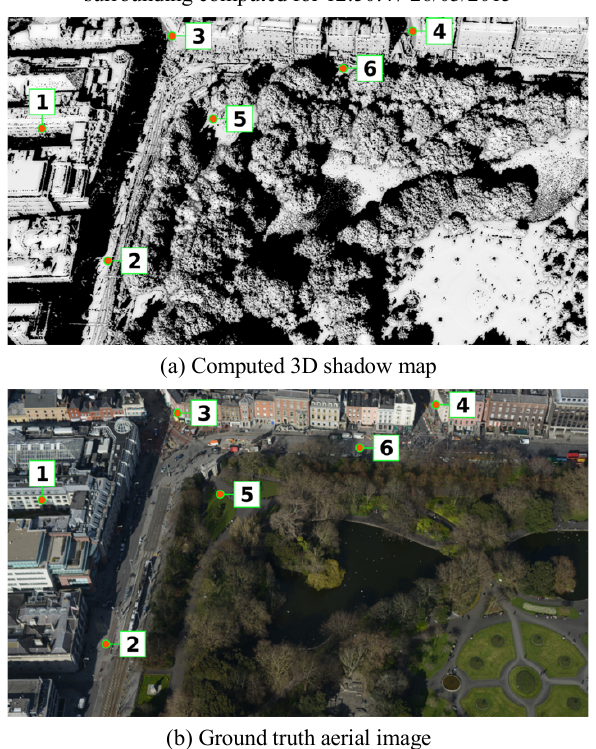
Figure 4. 3D shadow point cloud of the North-West corner of St. Stephen’s Green computed for 15:02:19